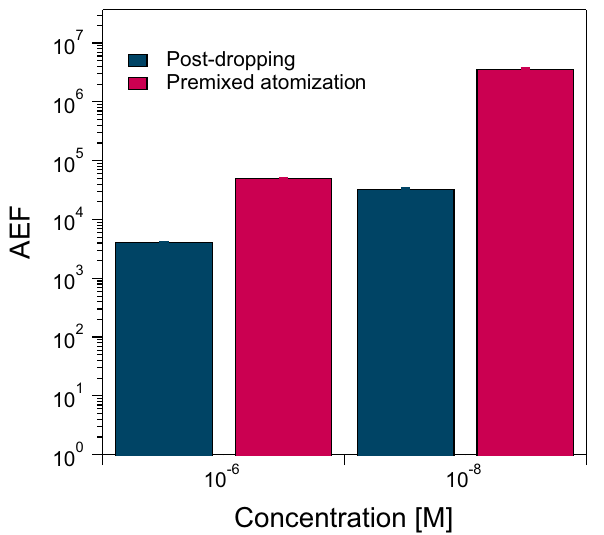
Figure 7. AEF values obtained from the 86 nm AgNP aggregates in the post-dropping and premixed atomization routes.